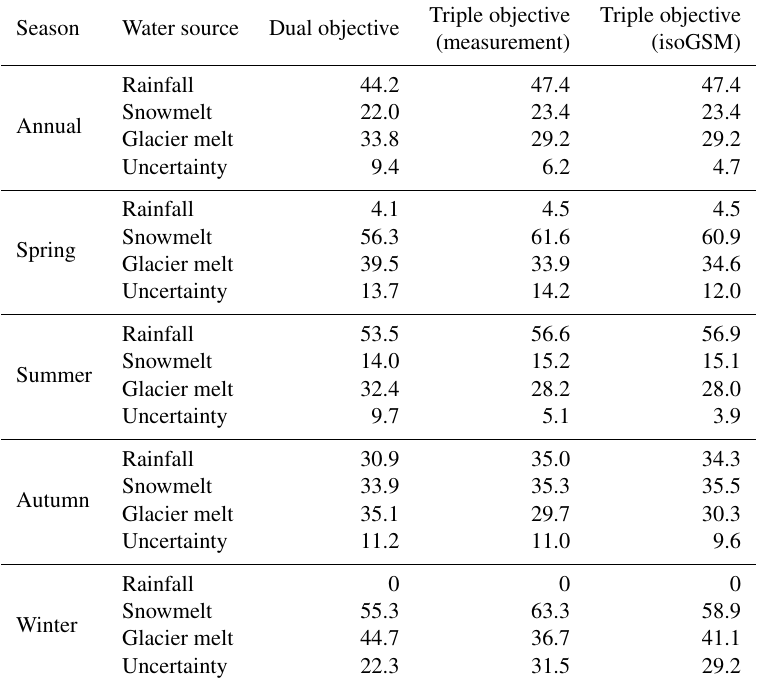
Table 6. Average proportions of water sources in the annual and seasonal water inputs for runoff generation in the KR